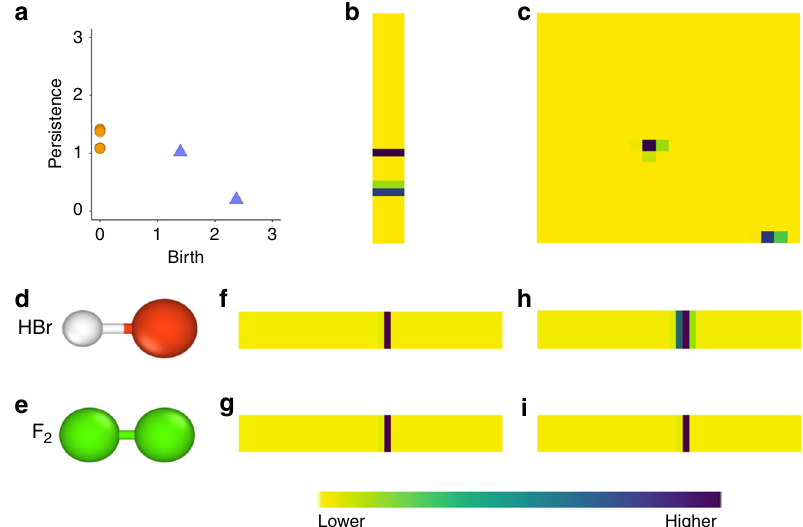
Fig. 2 Generation of a persistence image (PI) from a persistence diagram (PD). a PD of anisole, as shown in Fig. 1. The PI for b connected components and c holes. The molecules d HBr and e F 2 have the same bond length, resulting in equivalent features on the persistence diagram. Without incorporating the chemically driven PI, the representations in f and g are equivalent. By incorporating the pairwise electronegativity difference into the variance of the Gaussian kernel, the input vectors h and i for the two molecules are distinguished by the variance of the vector for